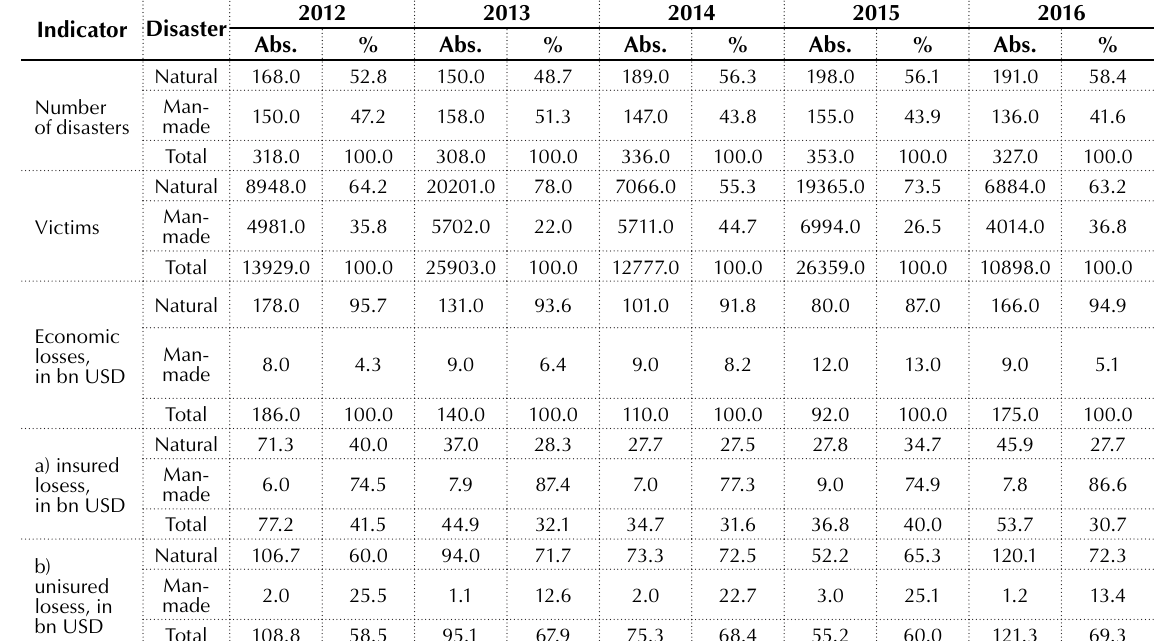
Source: compiled by the author based on Swiss Re Institute’s data.